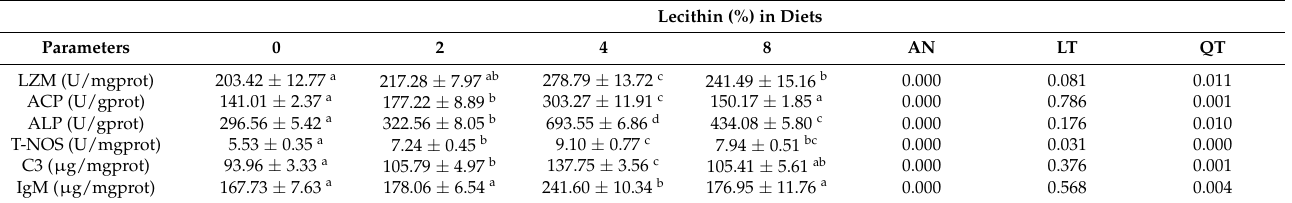
Table 8. Effects of dietary soybean lecithin on the immune parameters in the intestine of largemouth bass. Lecithin (%) in Diets